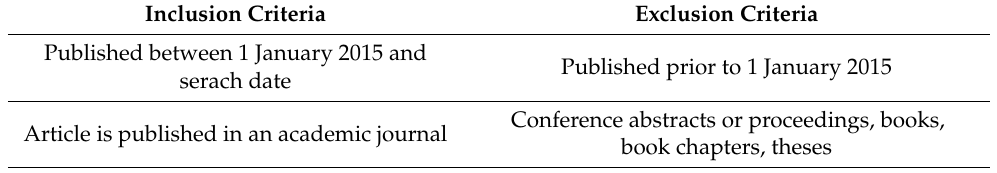
Table 1. Inclusion and Exclusion